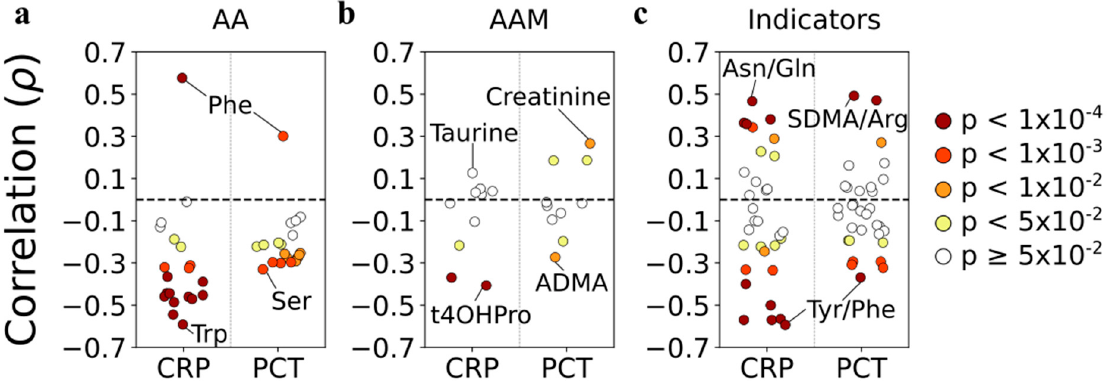
Figure 6. Correlations between amino acids, amino acid metabolites, and metabolism indicators and CRP and PCT in CAP. The analysis is based on values measured in all CAP samples (d1-f2). Y − axis values correspond to Pearson’s rho; p values are indicated by the fill color of the circles. ( a ) Amino acids. ( b ) Amino acid metabolites. ( c ) Metabolism indicators. AA—amino acids. AAM— amino acid metabolites.